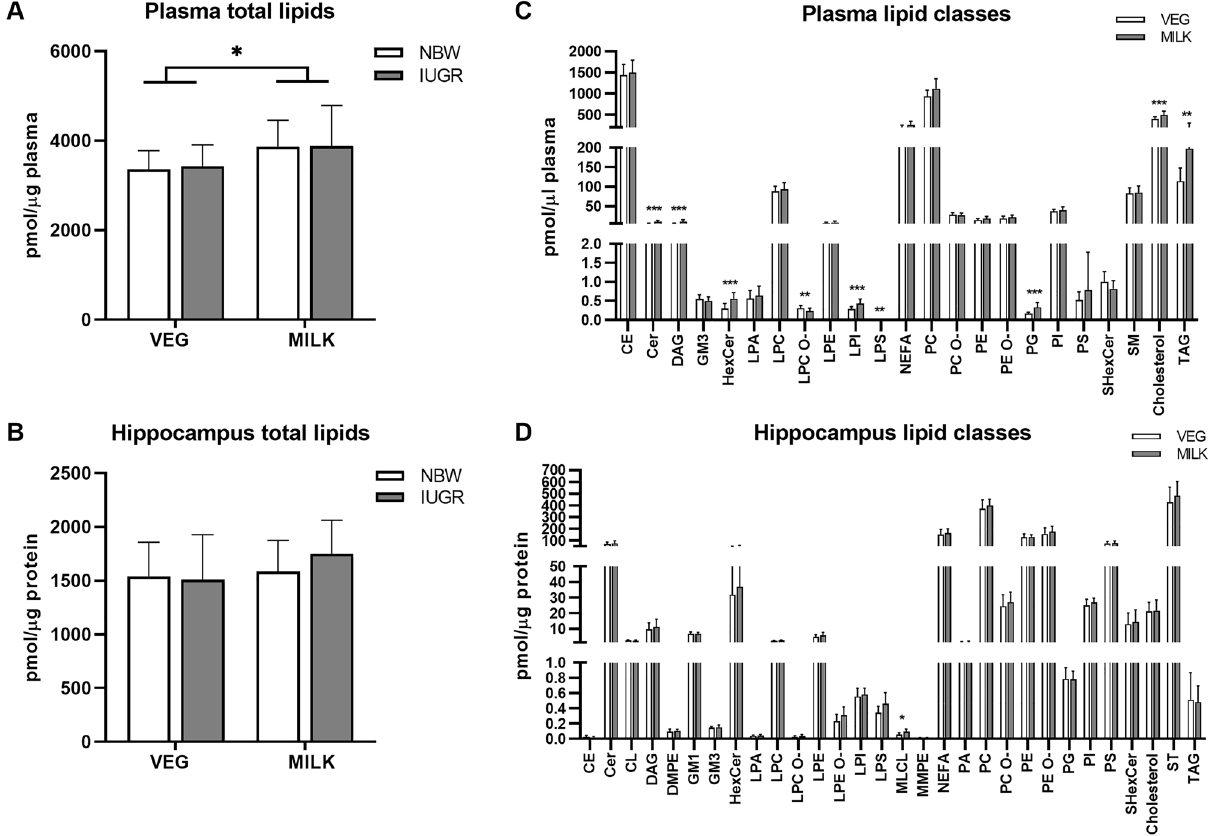
Figure 2. Total lipids ( A , B ) and lipid class abundances ( C , D ) in plasma and hippocampus on day 21–22. In ( A ) and ( B ), n = 9. In ( C ) and ( D ), data are pooled and presented as main effects of diet (n = 16–18). Data are shown as mean ± SD. All data were analysed using a linear mixed model. A Benjamini–Hochberg correction was applied in ( C ) and ( D ). Statistically significant differences between groups are shown as *p < 0.05, **p < 0.01 and ***p < 0.001. All figures were created with GraphPad Prism (version 9.3.0, GraphPad Software, San Diego, California, USA). VEG vegetable oil, MILK bovine milk fat, NBW normal birth weight, IUGR intrauterine growth restricted, CE cholesteryl ester, Cer ceramide, CL cardiolipin, DAG diacylglycerol, DMPE dimethyl- phosphatidylethanolamine, GM1 monosialotetrahexosylganglioside, GM3 monosialodihexosylganglioside, HexCer hexosyl ceramide, LPA lysophosphatidic acid, LPC lysophosphatidylcholine, LPC O- lysoalkylphosphatidylcholine, LPE lysophosphatidylethanolamine, LPE O- lysoalkylphosphatidylethanolamine, LPI lysophosphatidylinositol, LPS lysophosphatidylserine, MLCL monolysocardiolipin, MMPE monomethyl- phosphatidylethanolamine, NEFA non-esterified fatty acid, PA phosphatidic acid, PC phosphatidylcholine, PC O- alkylphosphatidylcholine, PE phosphatidylethanolamine, PE O- alkylphosphatidylethanolamine, PG phosphatidylglycerol, PI phosphatidylinositol, PS phosphatidylserine, SHexCer Sulfatide hexosyl ceramide, SM sphingomyelin, ST cholesterol, TAG MRI. Absolute total brain, grey and white matter volumes were lower in IUGR compared to NBW piglets (all p < 0.05) (Fig. 4B–D), but the percentage of grey and white matter did not differ between groups (Fig. 4E,F). There were no effects of diet or interactions between diet and birth weight.